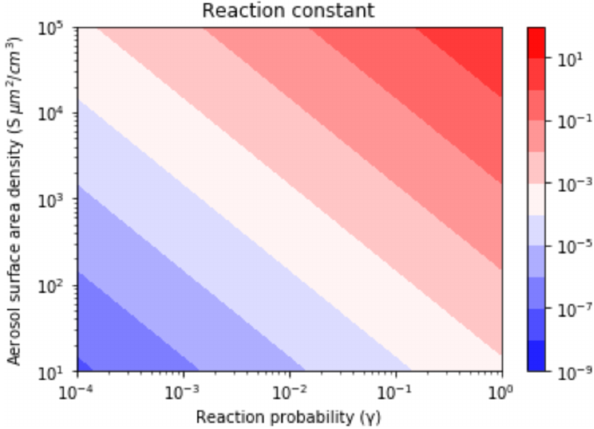
Figure 6. Contour lines of the same k N values as a function of 2 O 5 γ and S values. The γ values depend on aerosol composition and range from 3 . 8 × 10 − 5 (relatively dry sulfuric acid) to 1 (aqueous aerosol in the winter polar stratosphere). S values are a function of aerosol number density and size distribution and range from 52 (low scavenging rate, low particle growth rate) to 1140.1 (high scaveng- ing rate, high particle growth